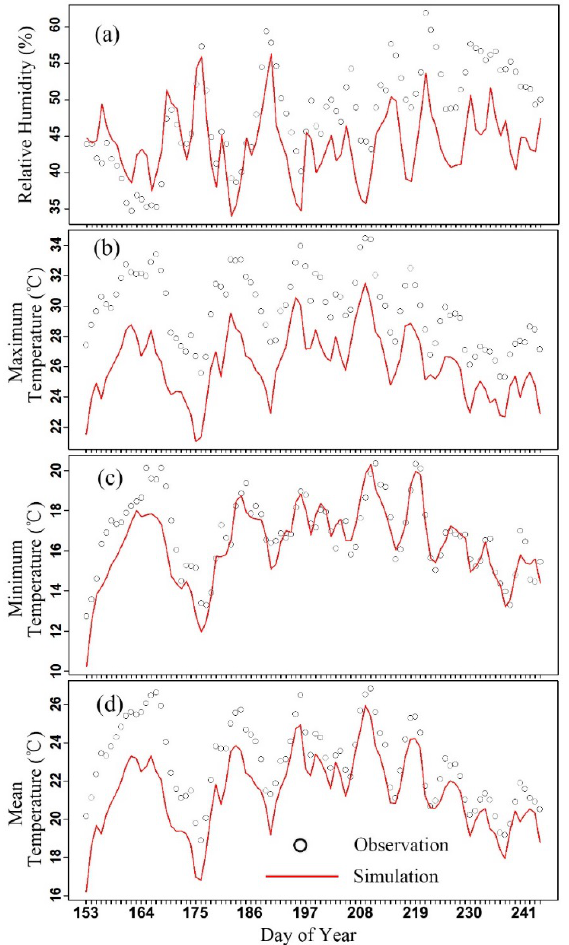
Figure 3. Comparisons of the observed and simulated (CTL) average ( a ) relative humidity, ( b ) maximum temperature, ( c ) minimum temperature and ( d ) mean temperature over all the 53 national stations in the summer of 2016.